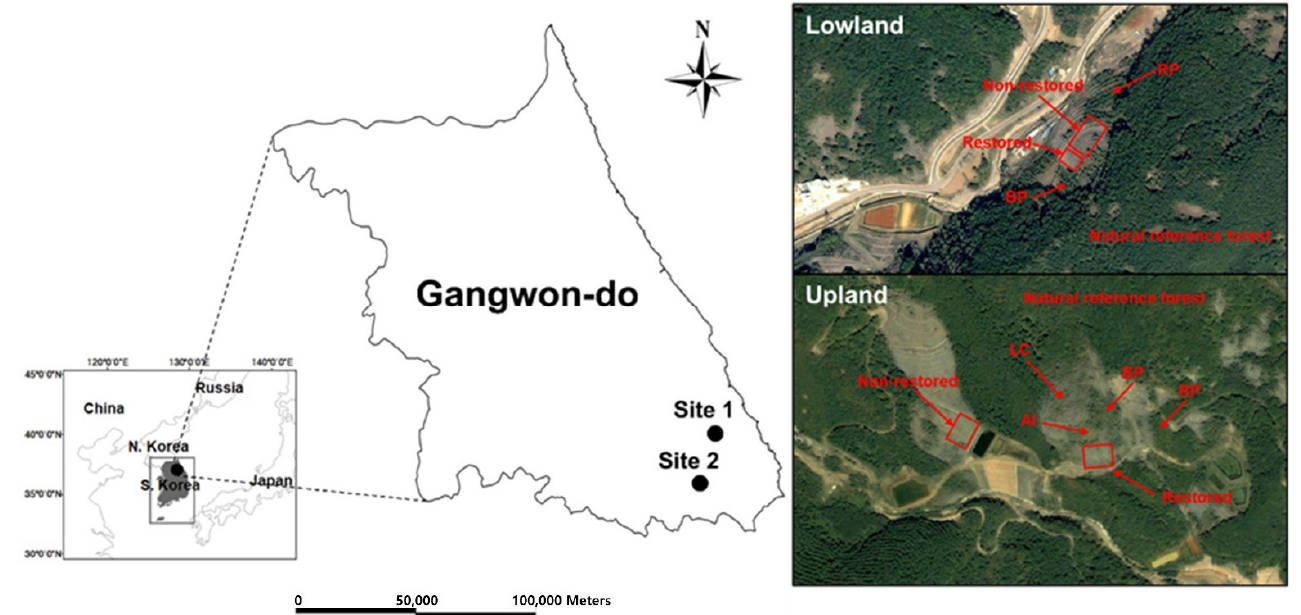
Figure 1. A map showing the study sites of the abandoned coal mine. Do indicates the administrative unit corresponding to the province. BP: Betula platyphylla var. japonica , RP: Robinia pseudoacacia , LC: Lespedeza cyrtobotrya , AI: Alnus incana subsp. hirsuta.